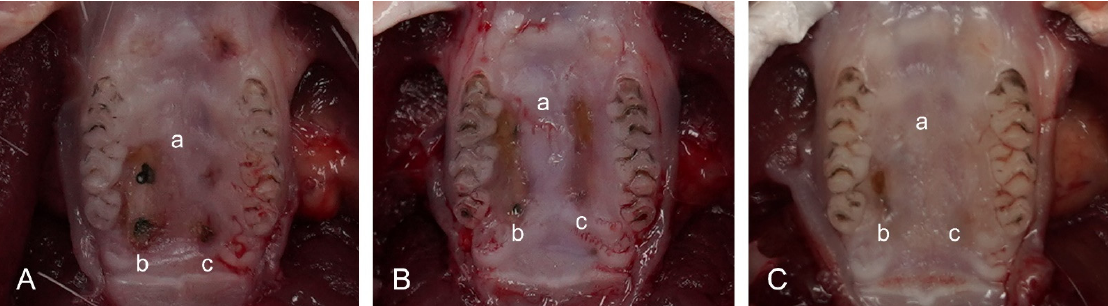
Figure 3. Photos taken at 3 days ( A ), 7 days ( B ), and 14 days ( C ) after surgery; a: steel scalpel, b: laser A group, c: laser B